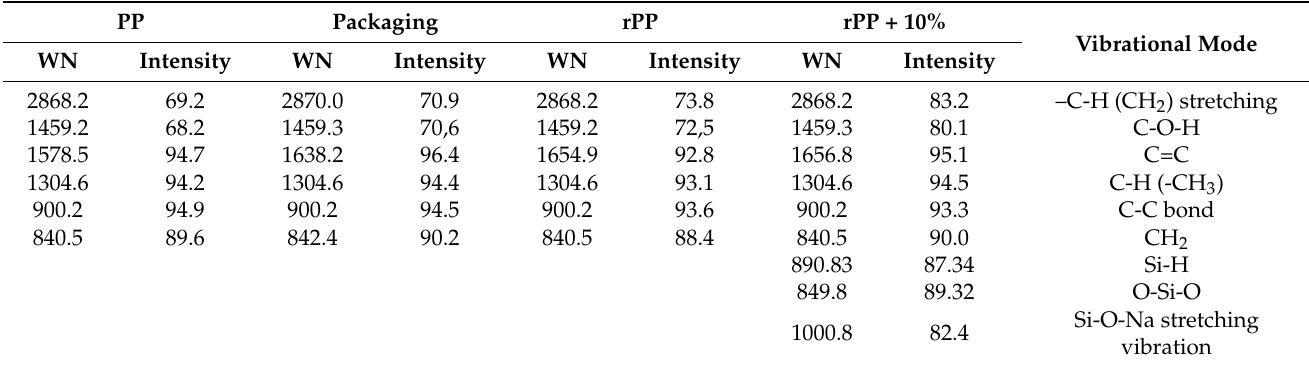
Table 4. FTIR analysis.